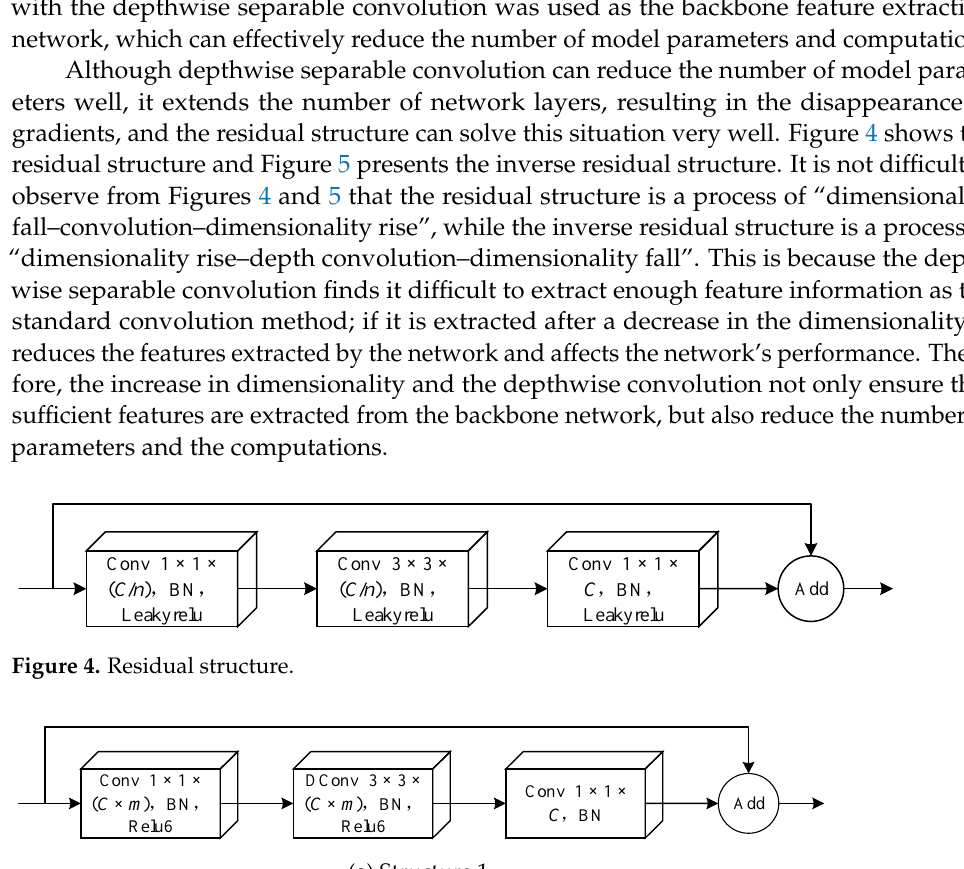
Table 1. Adopted MobileNetv2 structure.